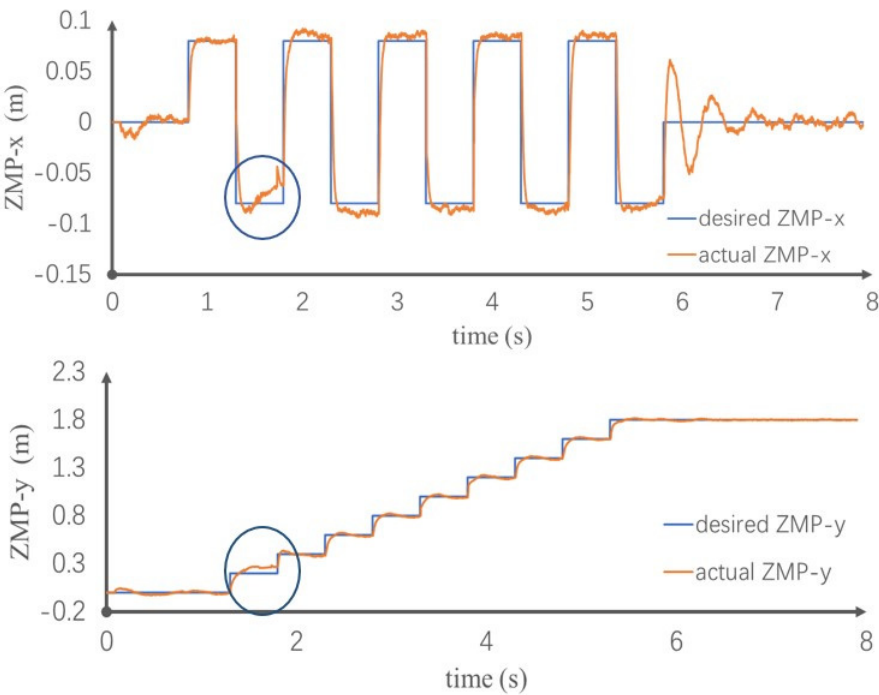
Figure 9. Zero moment point ( ZMP) tracking in x and y directions.